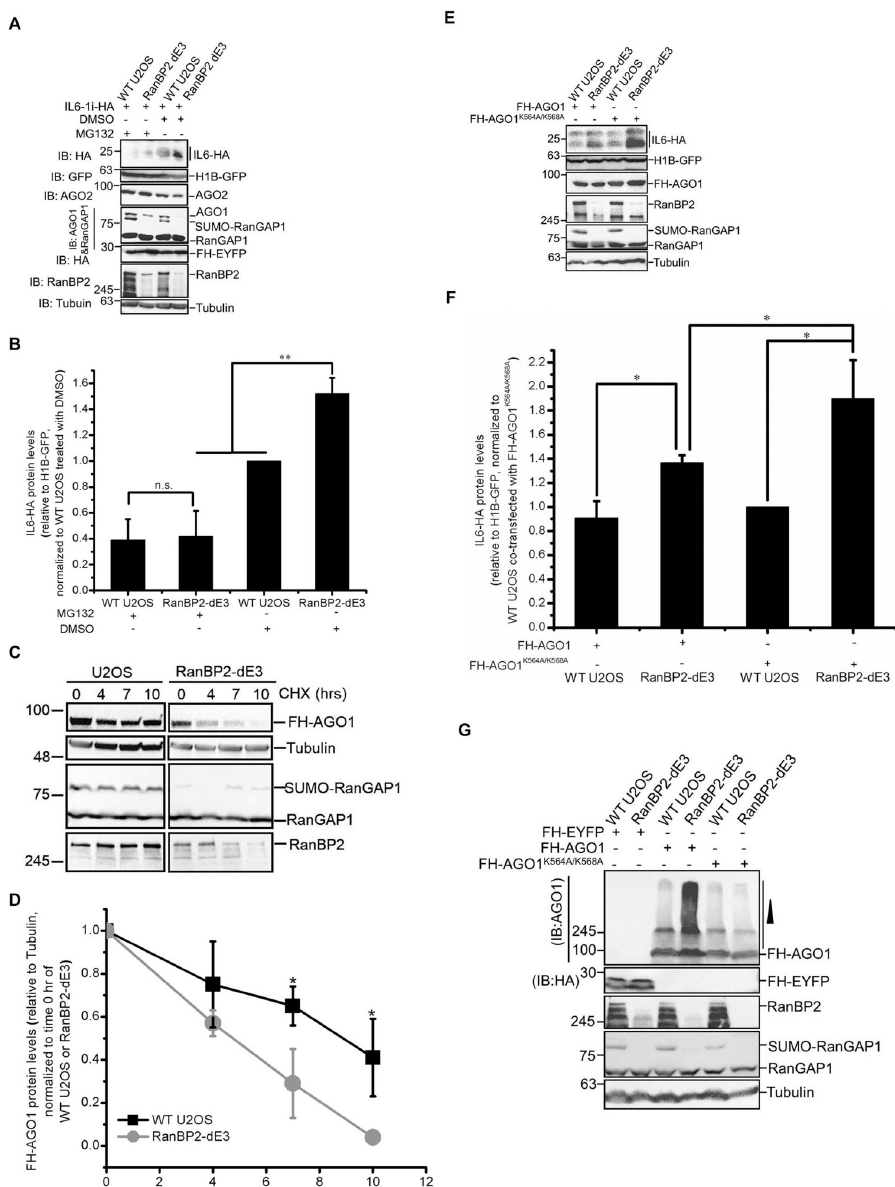
Fig 6. RanBP2 represses IL6 expression by promoting AGO1 stabilization. (A-B) Unmodified and RanBP2-dE3 U2OS cells were co-transfected with plasmids for an intron-containing IL6 construct ( IL6-1i-HA ), histone 1B-GFP ( H1B-GFP ) and Flag-HA-tagged yellow fluorescent protein ( FH-EYFP ). 18 h post-transfection, cells were treated with MG132 (10 μ M) (MG132 “+”), or DMSO (MG132 “-”), for an additional 7 h. Cell lysates were collected, separated by SDS-PAGE, and immunoblotted with antibodies against HA, GFP, AGO2, AGO1, RanGAP1, RanBP2 and α -tubulin (A). Note that AGO1 and RanGAP1 were blotted together. Also note that DMSO-treated RanBP2-dE3 cells had no detectable AGO1. MG132-treatment led to an increase in AGO1, AGO2 and mutant RanBP2-dE3 levels. In contrast, the same treatment led to a decrease in IL6-HA levels. IL6-HA and H1B-GFP protein levels were quantified using densitometry analysis and the ratio of IL6-HA/H1B-GFP was normalized to DMSO-treated unmodified U2OS cells (B). Each bar is the average of three independent experiments ± SEM. (C-D) Unmodified and RanBP2-dE3 U2OS cells were transfected with Flag-HA-tagged AGO1 ( FH-AGO1 ). 24 h post-transfection, the cells were treated with cycloheximide (CHX, 100 μ M) for various amounts of time to block further translation and thus allowing us to determine the rate of AGO1 turnover. Cell lysates were collected, separated by SDS-PAGE, and immunoblotted with antibodies against HA (FH-AGO1), α -tubulin, RanGAP1 and RanBP2 (C). For each time point, FH-AGO1 and α - tubulin protein levels were quantified using densitometry analysis and the ratio of FH-AGO1/ α -tubulin